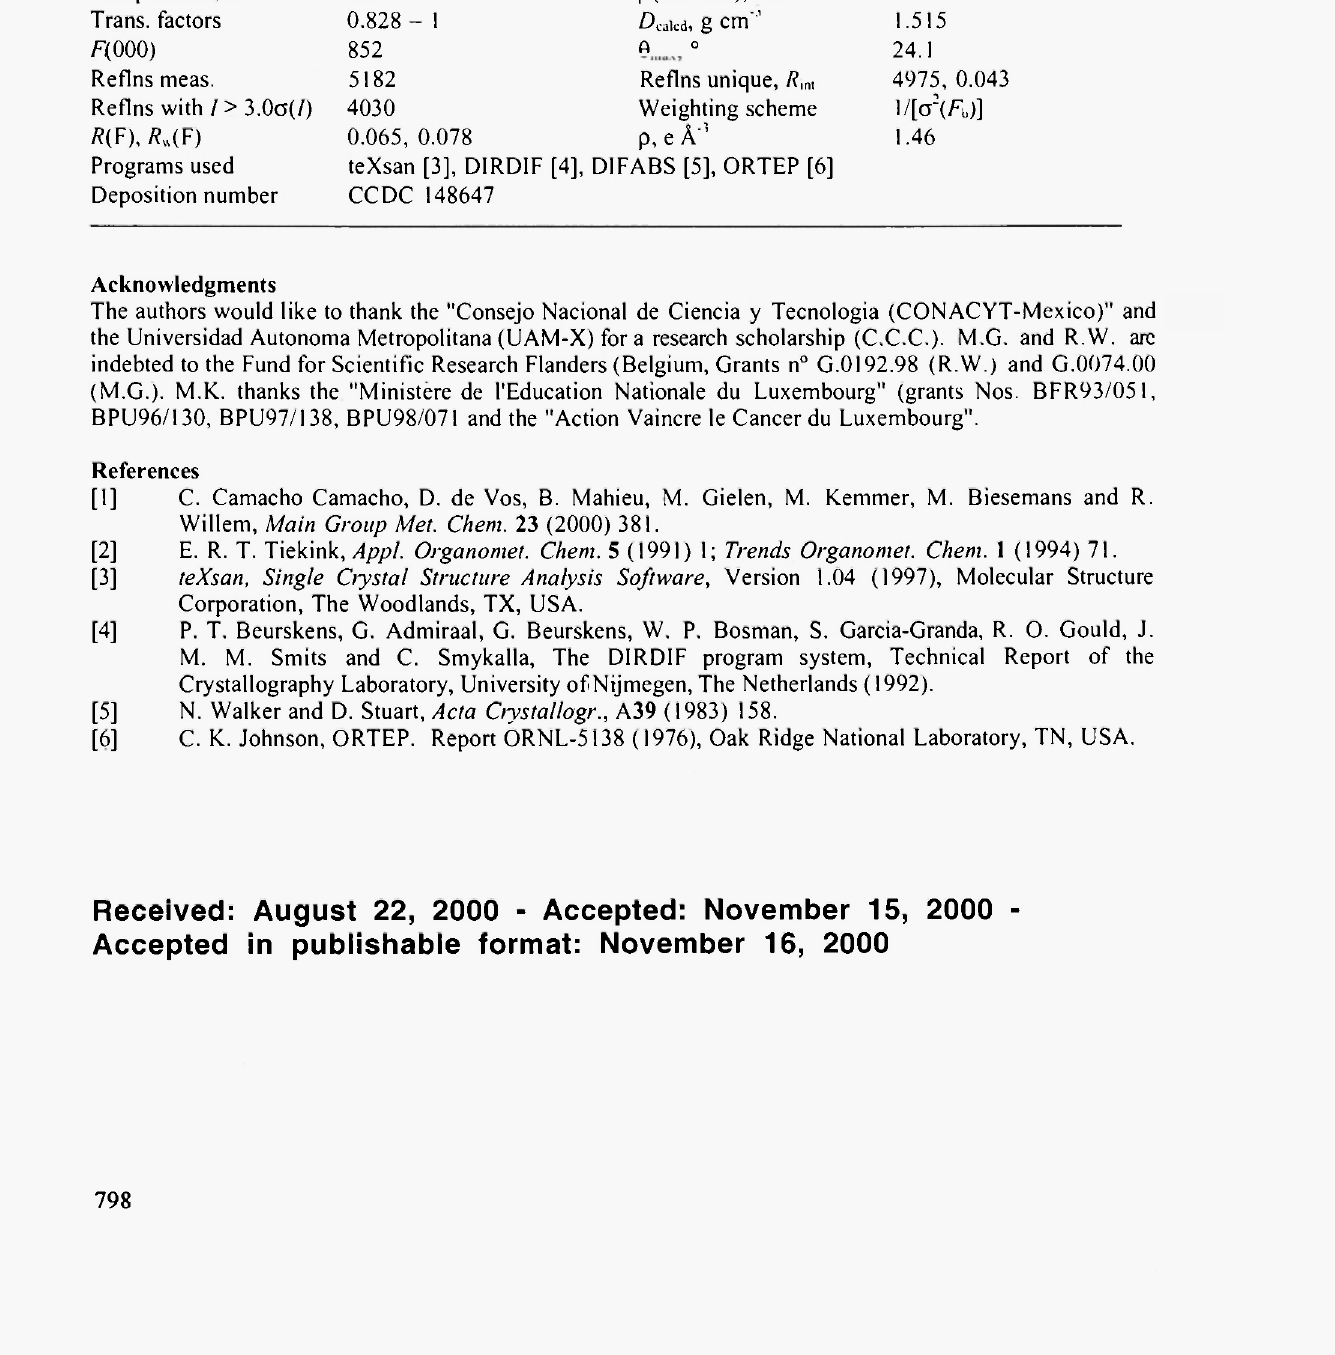
Table 1. Crystal data for [{nBu : Sn(0;CH2(C7H502))| 2